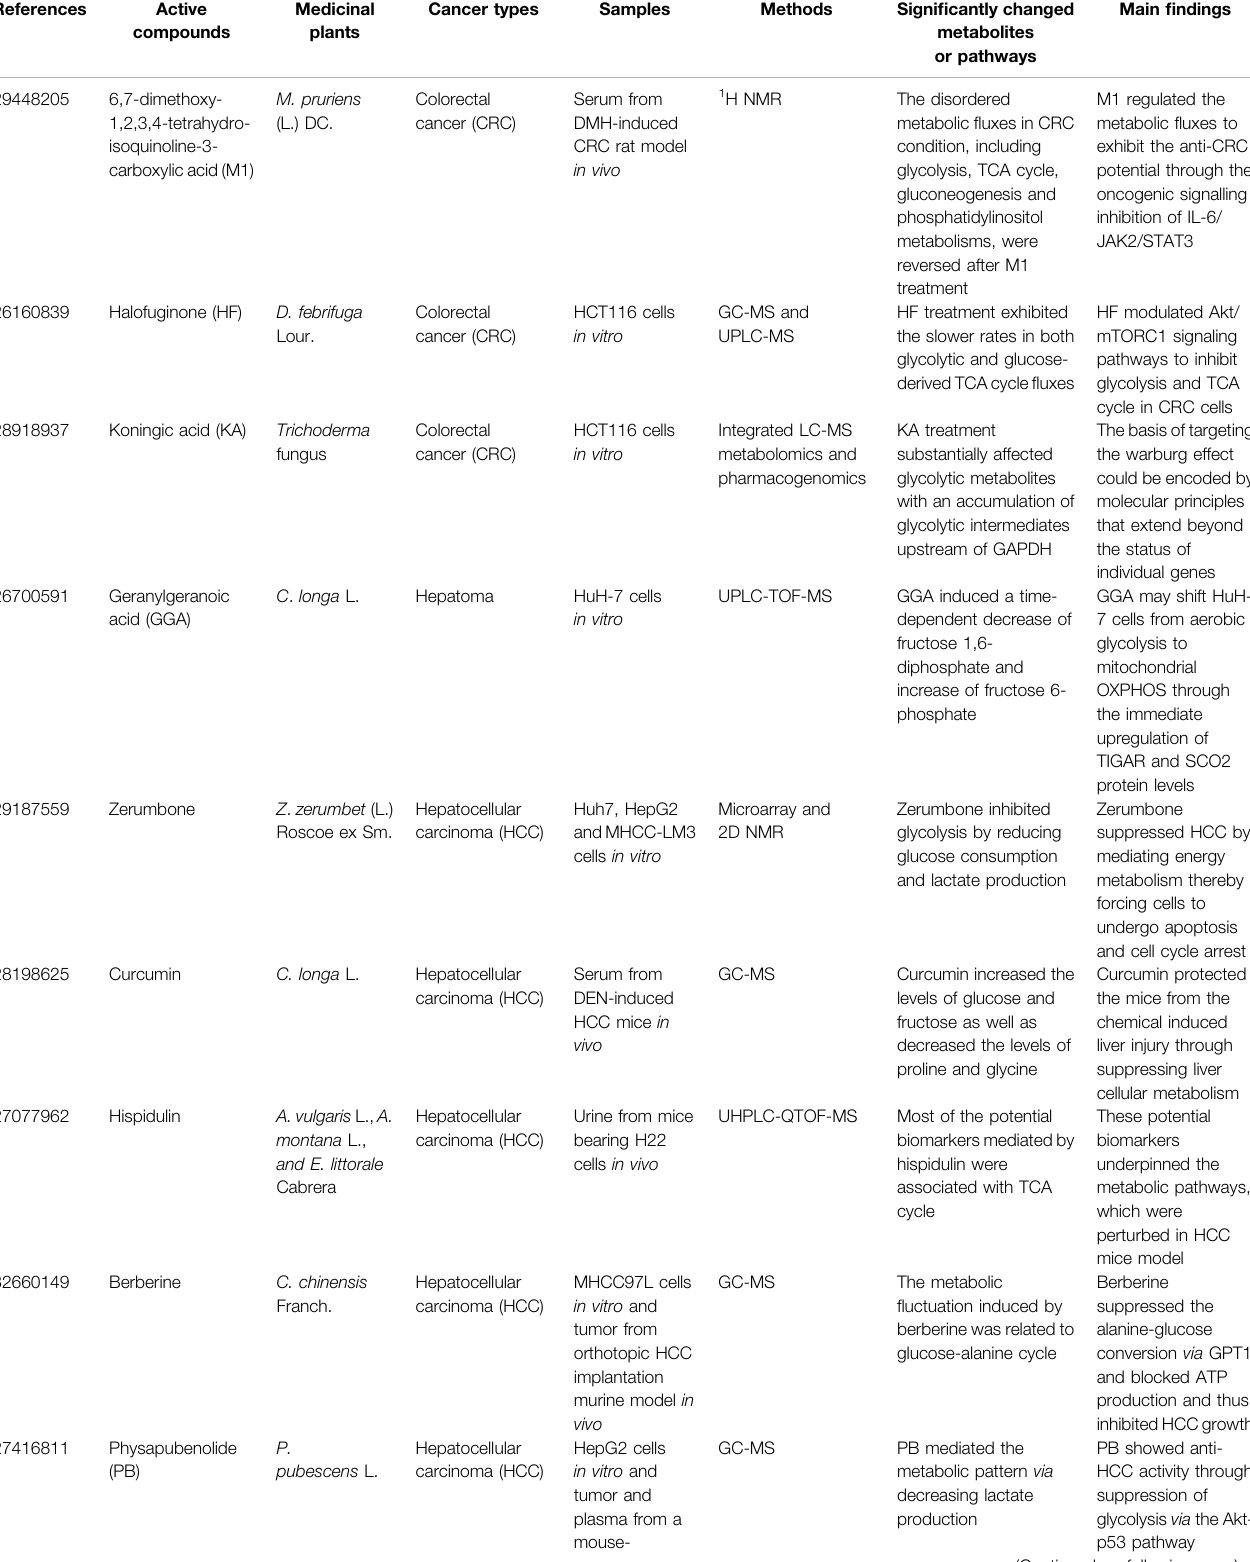
TABLE 1 | The summary of recent metabolomics investigations on anti-GIC therapies of active compounds from medicinal